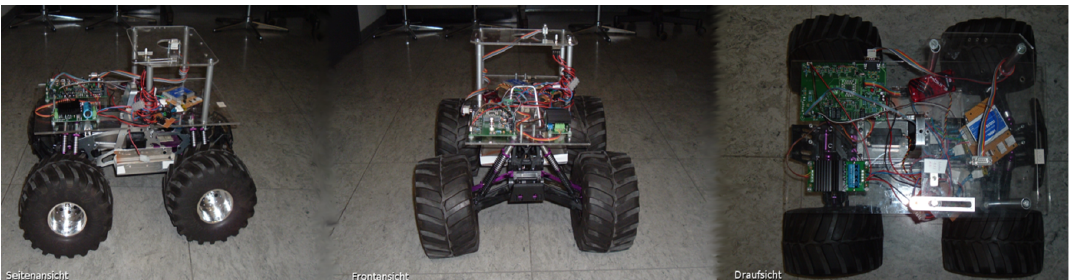
Figure 1. HPI Savage 2.1 monster truck with robot attachment.